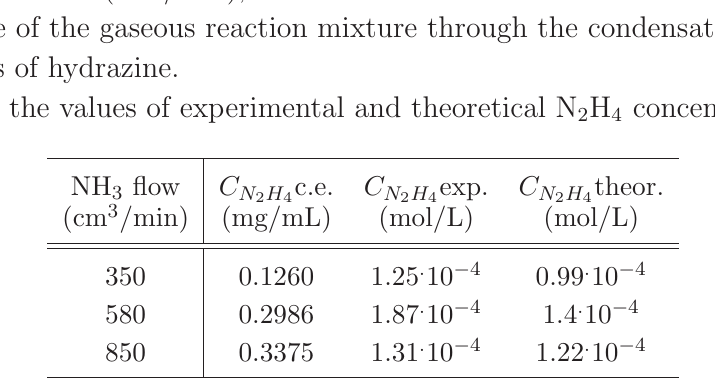
Table 3 Values of experimental and theoretical N 2 H 4